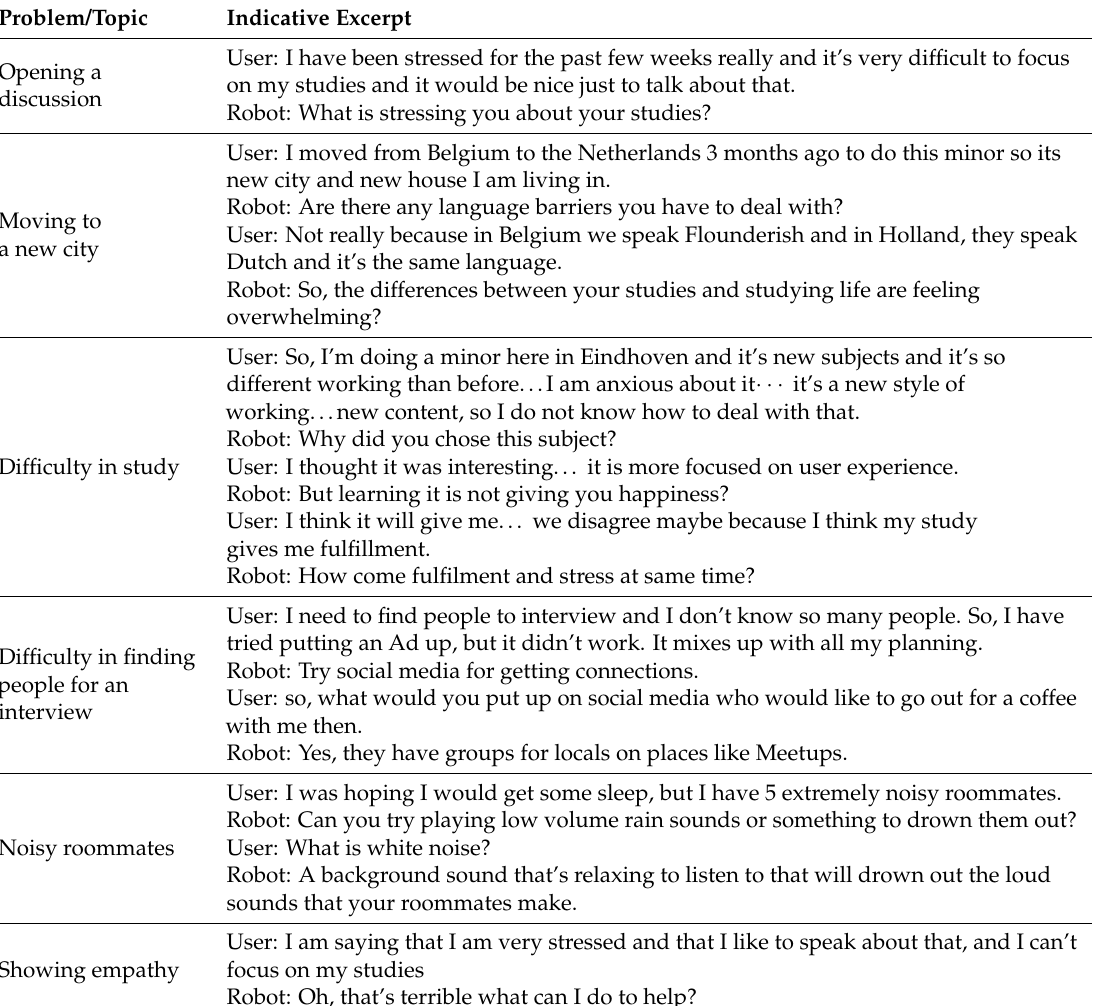
Table 3. Problems or situations mentioned by an actress during sessions and examples of corresponding crowd